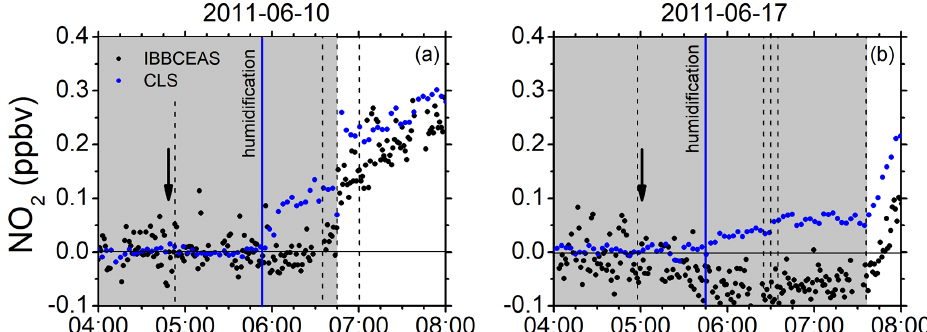
Figure 5. Examples of the small increase in NO 2 mixing ratios upon humidification in the dark chamber measured with CLS (blue dots) in comparison to those measured with IBBCEAS (black dots). (a) 10 June 2011: CO 2 added (04:53UTC), humidification started (05:52UTC – vertical solid blue line), ozone added (06:36UTC), roof opened (06:46UTC), and isoprene added (07:01UTC). (b) 17 June 2011: flushing of chamber stopped (04:58UTC), humidification started (05:45UTC), humidification ended (06:25UTC), O 3 added (06:30UTC) in dark chamber, CO added (06:35UTC), and roof opened (07:36UTC). Vertical solid arrows indicate the time of the zeroing measurement ( I 0